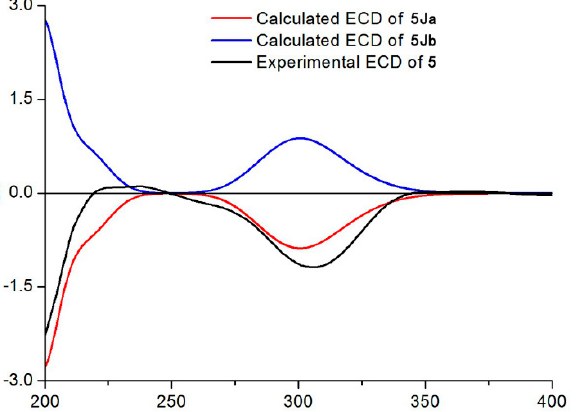
Figure 5. Experimental ECD spectrum of 5 and calculated ECD spectra of 5Ja and 5Jb .